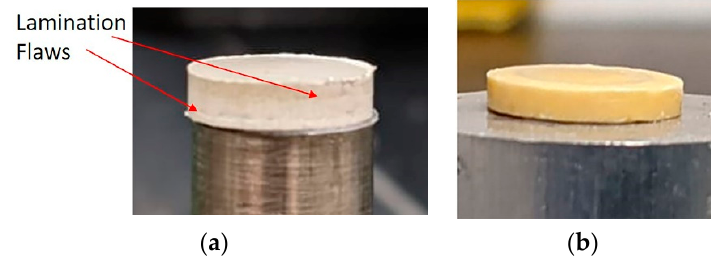
Figure 4. PZT–ZnO 3-0 composite placed on a metal cylinder after ( a ) the binder burn out step containing lamination defects, and ( b ) after the cold sintering step.